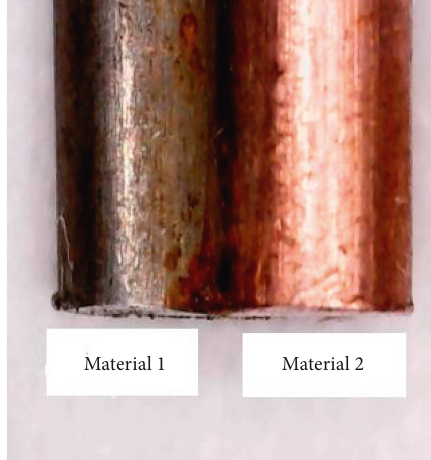
Figure 2: Multimaterial electrode work photos.